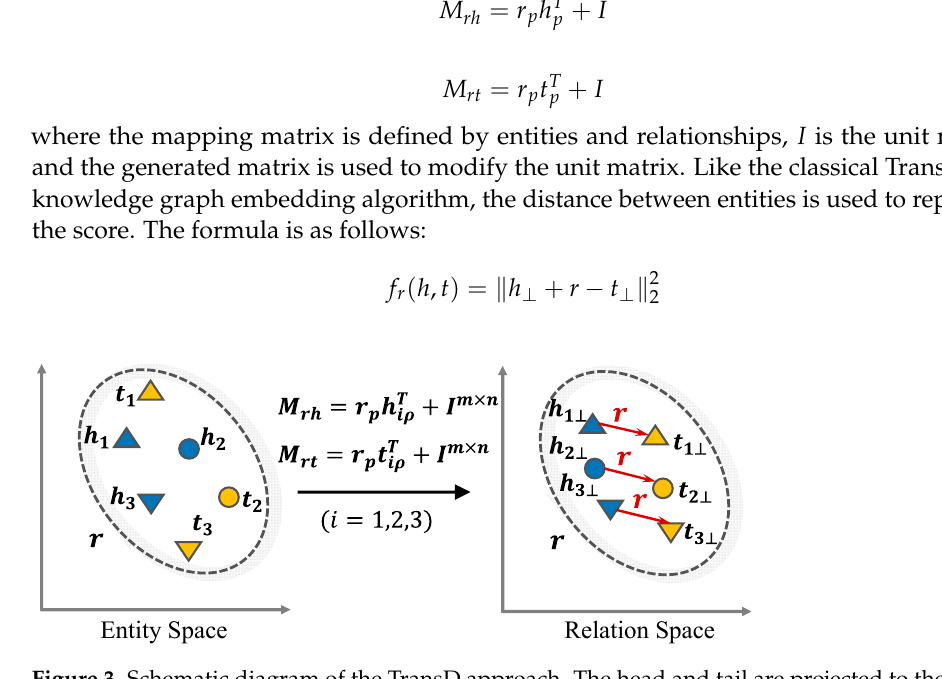
Figure 3. Schematic diagram of the TransD approach. The head and tail are projected to the hyper- plane through the transition matrix and connected by relationships.